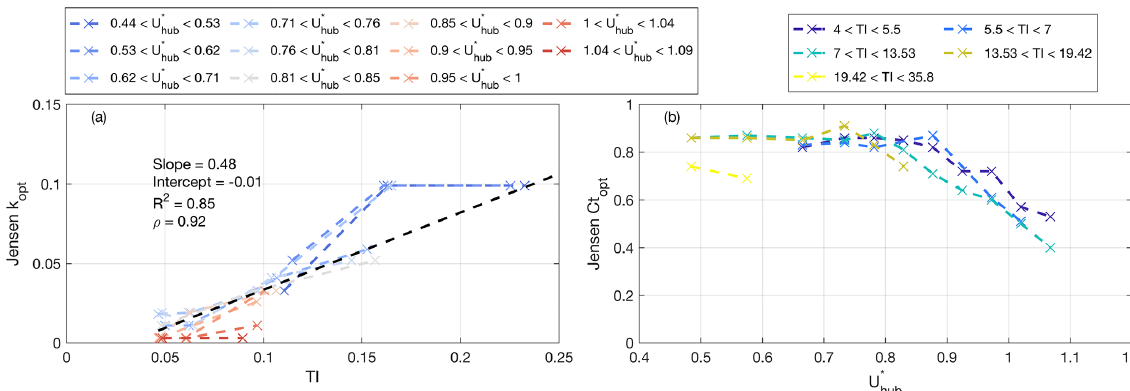
Figure 2. Optimal tuning of the Jensen wake model: (a) optimized wake expansion coefficient, k opt , as a function of the incoming-turbulence intensity, TI, and colored by the normalized incoming wind speed at hub height, U ∗ . The dashed black line is the linear fitting; (b) optimized hub thrust coefficient, C t , as a function of U ∗ and colored according to TI. hub opt